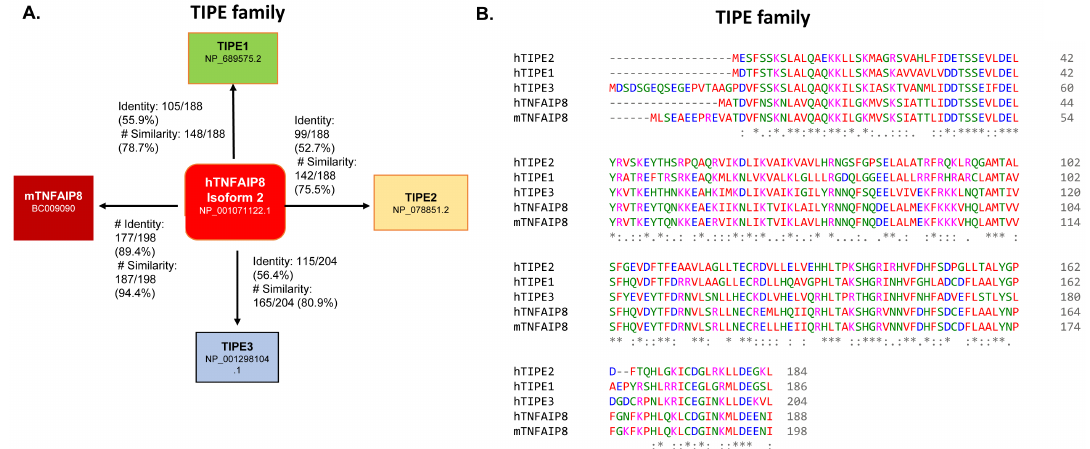
Figure 1. ( A ) Amino acid similarity and identity of TIPE family members, TIPE1, TIPE2, TIPE3,